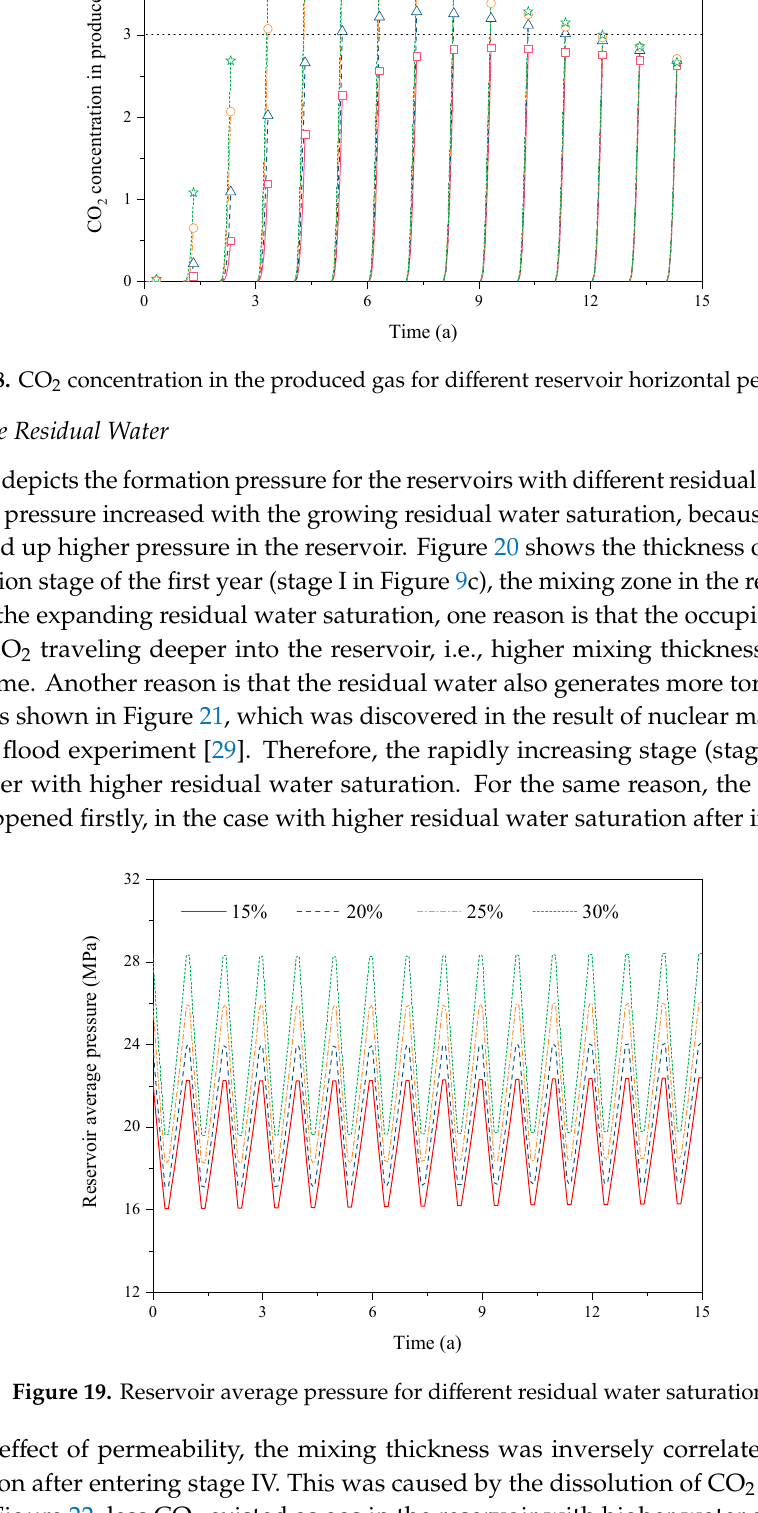
Figure 17. Thickness of the mixed zone for different reservoir horizontal permeabilities.